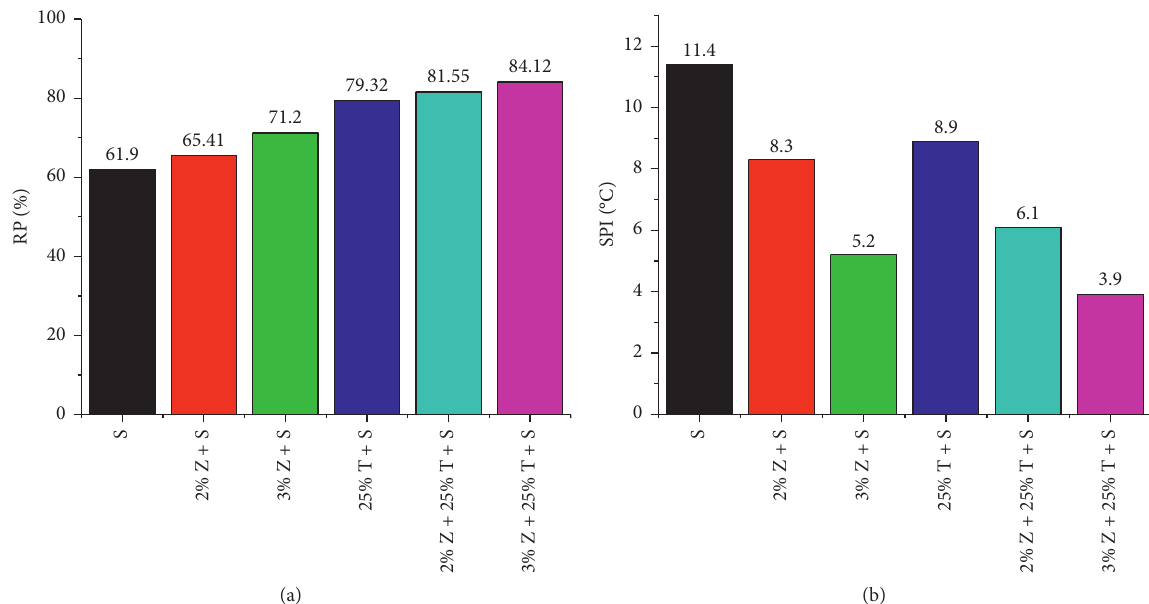
Figure 6: Effect of different content of nano-ZnO (Z) and TLA (T) on physical properties of SBS asphalt (S) after UV aging. (a) Residual penetration for asphalt. (b) Softening point increment for asphalt.